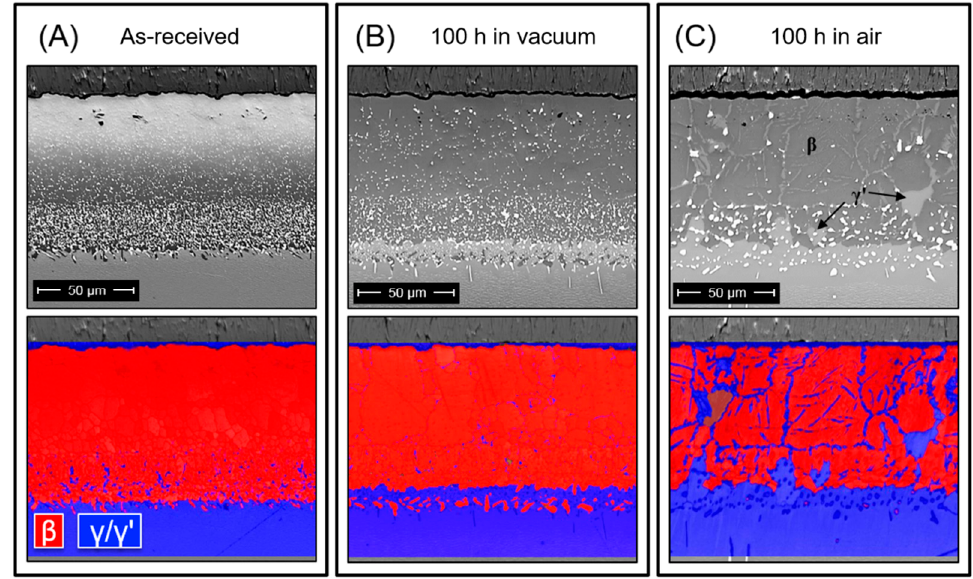
Figure 7. BSE imaging (top) and EBSD phase mapping (bottom) of the Pt-aluminide β bond coat: